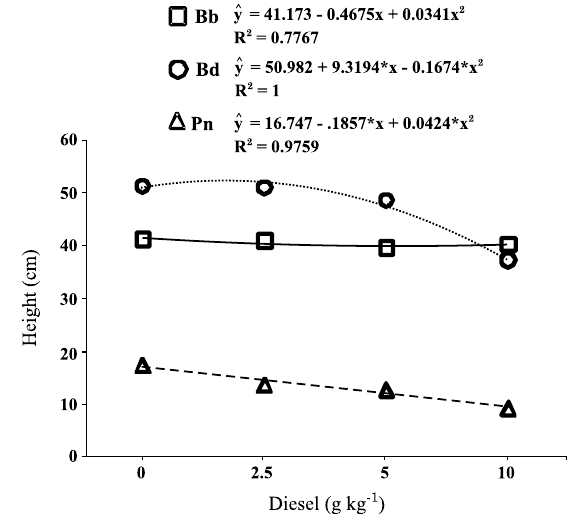
Figure 2. Brachiaria brizantha (Bb), Brachiaria decumbens (Bd) and Paspalum notatum (Pn) height (cm) as a function of diesel fuel levels (0, 2.5, 5 and 10 g kg -1 ) after 10 weeks of treatment. *: significant at 5 % based on the F